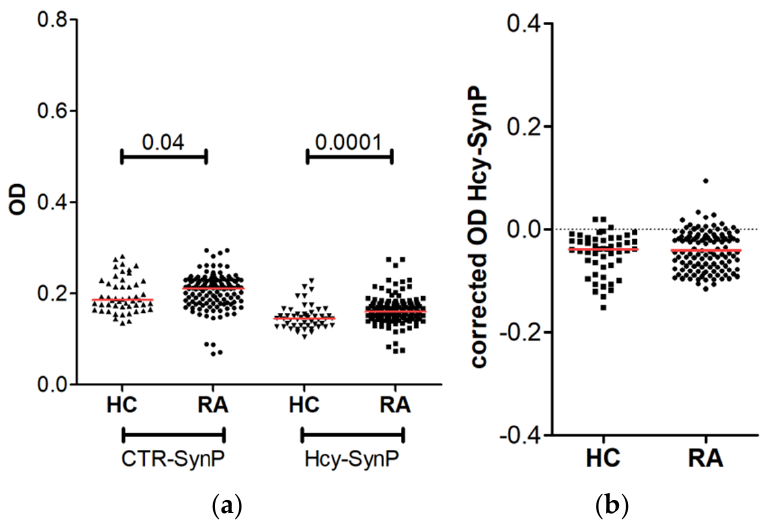
Figure 3. Reactivity against homocysteinylated SynP in RA patients and healthy controls. ( a ) Reactivity measured as OD before subtracting the OD against CTR-SynP; ( b ) specific reactiv- ity against Hcy-SynP after correction. The red line represents the median OD value in each